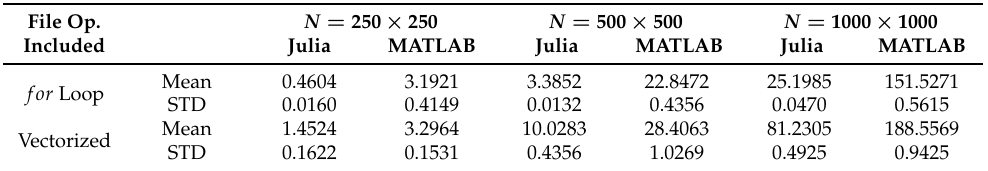
Table 3. Mean execution times and standard deviations of the heat equation solver written in MATLAB and Julia by including file operations. The mean execution times are given in second. Ten data points are used in the calculation of the mean and the standard deviation.